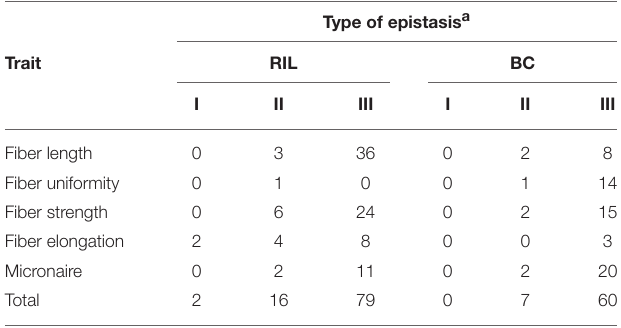
TABLE 6 | Types of epistasis detected for fiber quality traits in RIL and BC